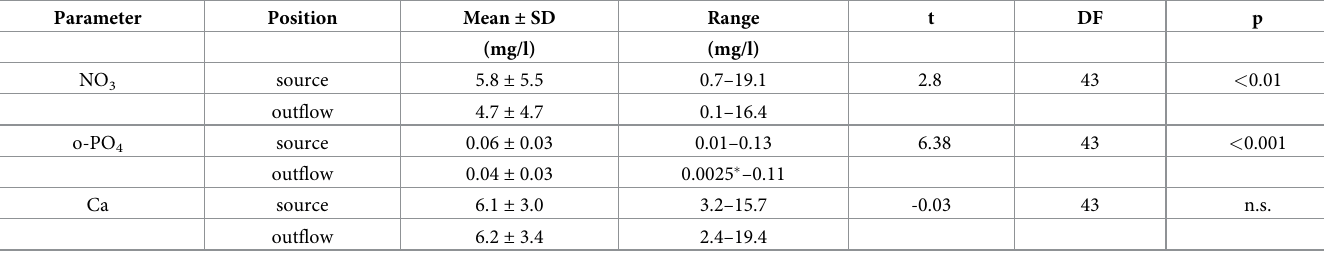
Table 2. Dissolved nutrients in the spring source and outflow and the significance of paired t-tests of these data (N = 44).